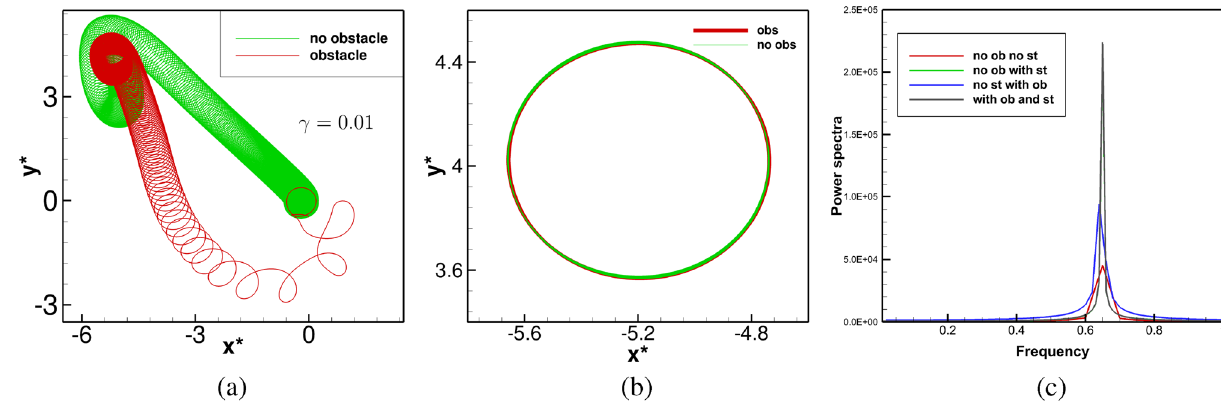
Figure 11. Tip trajectories of the spiral wave for γ = 0.01 with and without the obstacle in the time range: ( a ) 100 ≤ t ≤ 1500 , ( b ) 1100 ≤ t ≤ 1200 and, ( c ) power spectra of the time history of the y -coordinate of the tip trajectories for four different scenarios.